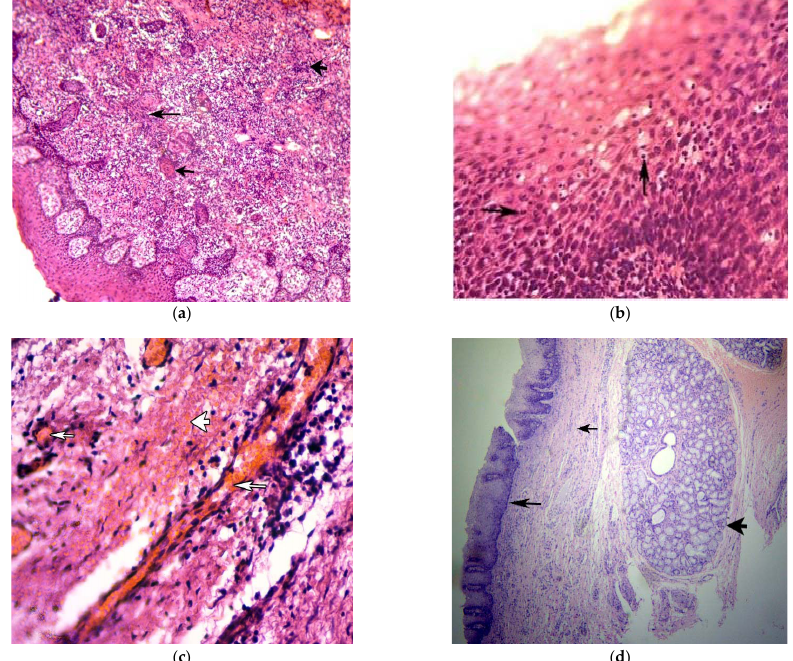
Figure 2. ( a ) Lymphoplasmocytic infiltration of the lamina propria of the oral mucosa in the patient with HCV. The large bold arrow marks the site of intense lymphoplasmocytic infiltration. Cell iden- tification was carried out at higher microscope magnifications. A thin, long arrow marks the site of incipient sclerosis of the lamina propria. A thin, short arrow indicates a dystrophically altered apex of the acanthotic strand of the epithelial cover (stained with hematoxylin–eosin, × 100). ( b ) Migration of the cells of the inflammatory infiltrate into the thickness of the epithelial layer of the oral mucosa in the patient with HCV (arrow; stained with hematoxylin–eosin, × 400). ( c ) A section of the own plate of the oral mucosa in a patient with HCV. There is swelling of the connective tissue with hem- orrhages in the thickness of the tissue (thick, short arrow), dilatation and a plethora of capillaries (short and long, thin arrows). Around the longitudinally cut, full-blooded blood vessel, the presence of mononuclear inflammatory cell infiltration is shown (thin, long arrow) (stained with hematoxy- lin–eosin, × 400). ( d ). A section of the oral mucosa in the patient with non-HCV. This material served as a control. The bold arrow indicates one of the two intact minor salivary glands with lobular ducts. The long, thin arrow indicates intact stratified squamous nonkeratinized epithelium. The short, thin arrow points to an intact lamina propria composed of delicate bundles of collagen fibers. There is scant to moderate mononuclear inflammatory cell infiltration in the left below part of lamina pro- pria (stained with hematoxylin–eosin, × 100). cytoplasmic vacuoles up to balloon dystrophy, death and desquamation of the epithelium with formation of micro-erosions. Comparing these five pathomorphological changes showed that mucous membrane fibrosis was detected in 96% of HCV patients with a sig- nificant difference from the non-HCV group ( p < 0.001). Changes caused by the develop- ment of mucous membrane sclerosis were determined in 100% of the cases in the HCV group. Immunohistochemical research of the biopsies of mucous oral membrane taken from patients with HCV led us to evaluate the quantitative composition of infiltrate to T-lym- phocytes (CD3+) and B-lymphocytes (CD20+).